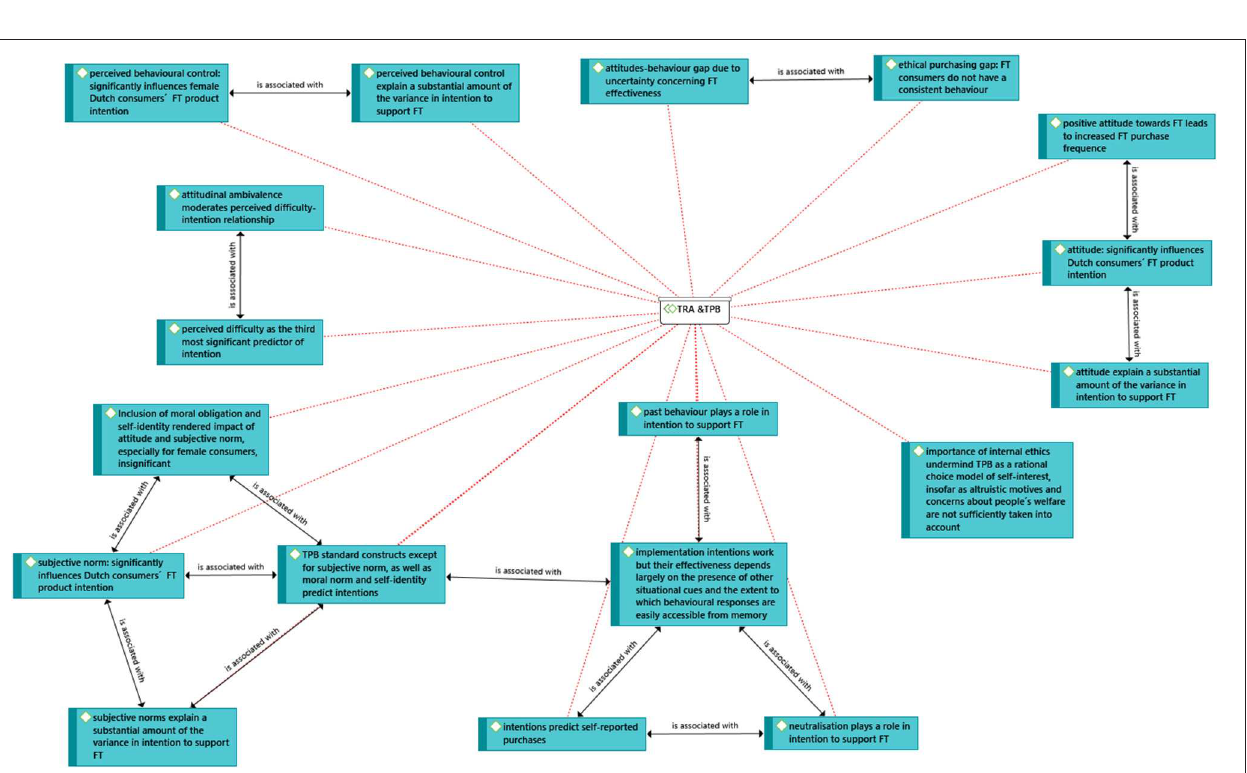
FIGURE 6 | Network analysis: TRA and